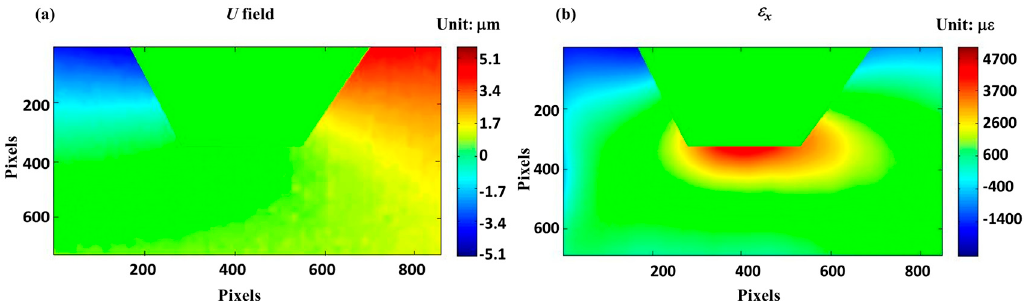
Figure 14. Calculated displacement and strain fields in horizontal direction under load 49.0 N: ( a ) U and ( b ) ε x . One pixel represents 0.55 μ m.